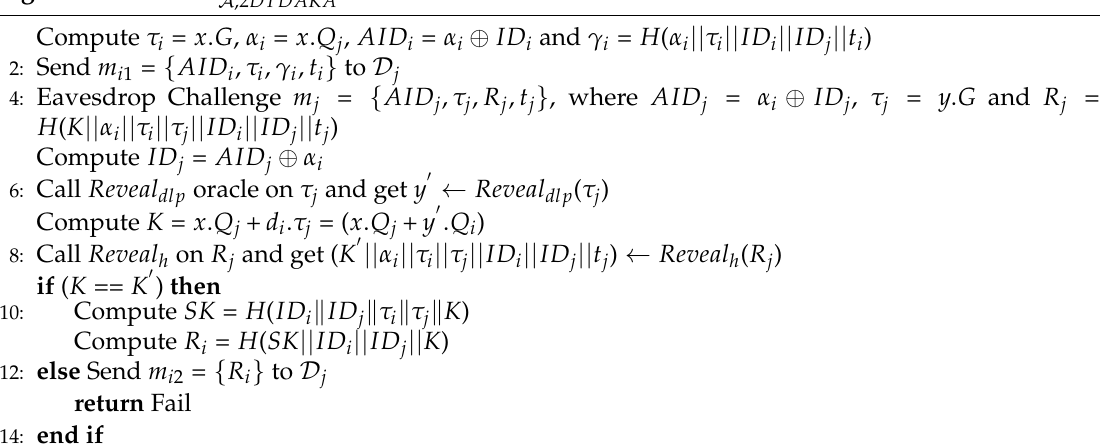
Algorithm 2 EXPE 2 ECDLP , HASH A ,2